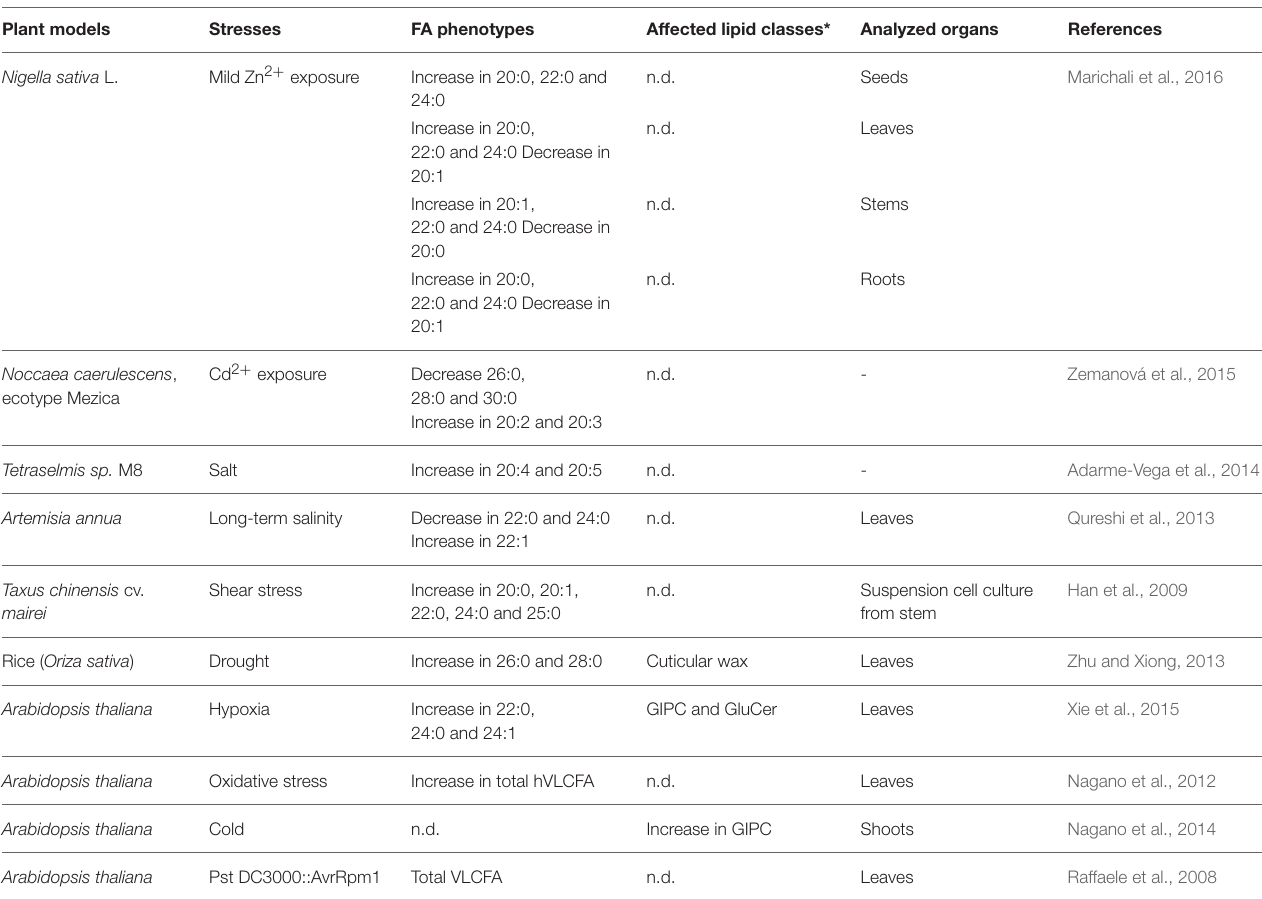
TABLE 2 | Changes in VLCFA levels under stressful